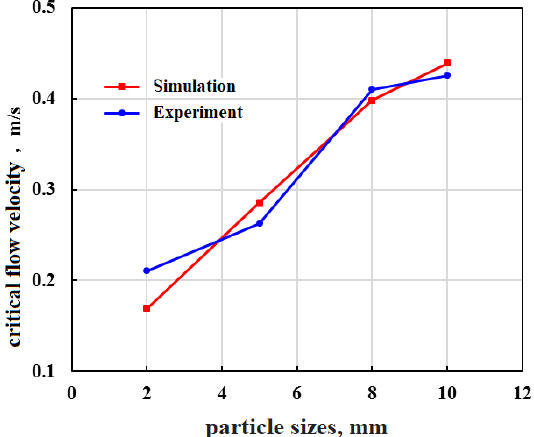
Figure 15. The experimental and theoretical curves of the critical velocity of particles under different hydrate volume fraction.